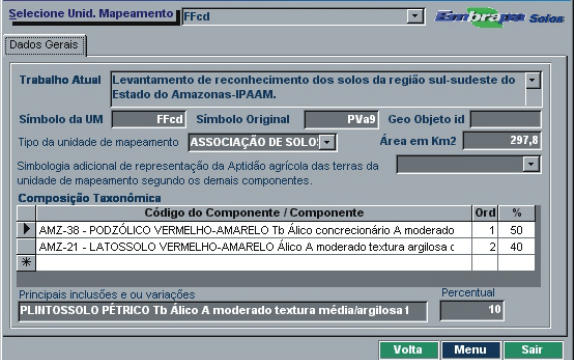
Figura 6. Tela principal da entidade unidade de